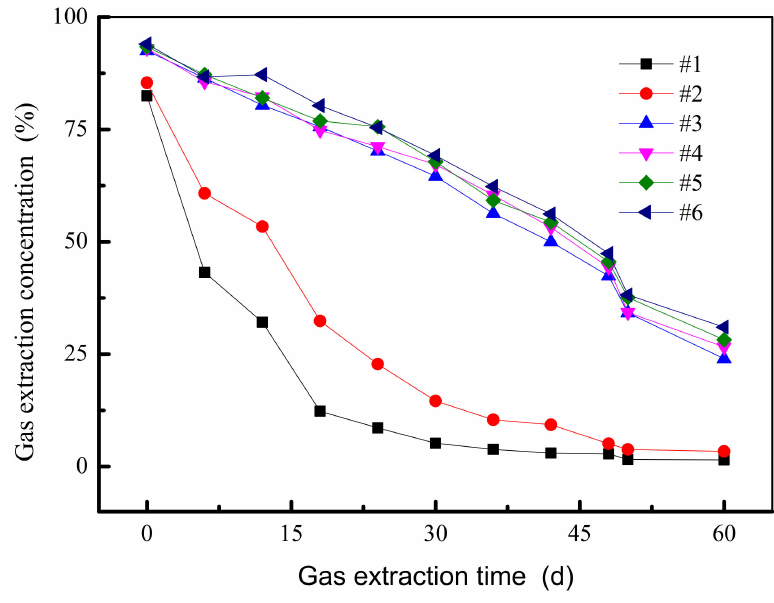
Figure 9. Drilling gas extraction